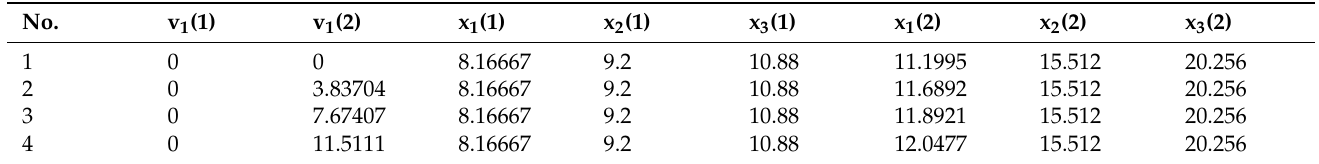
Table 5. Strategies of the first influence agent under fixed strategies of the Principal and the